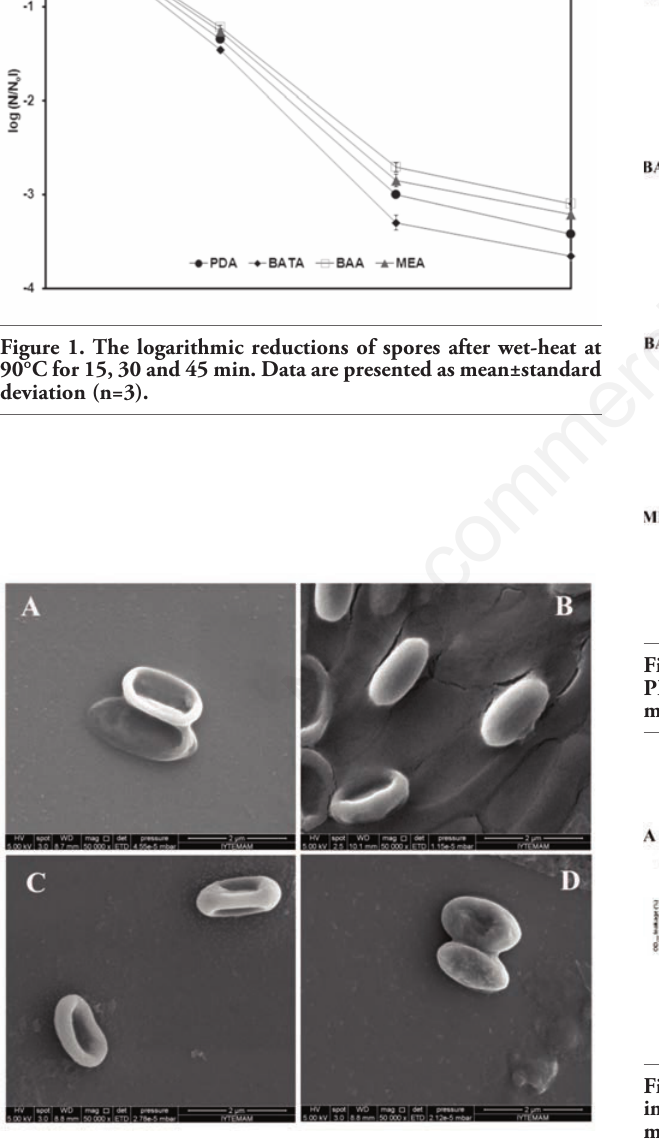
Figure 2. SEM images of untreated A. acidoterrestris spores (A) PDA, (B) MEA, (C) BATA, (D) BAA.